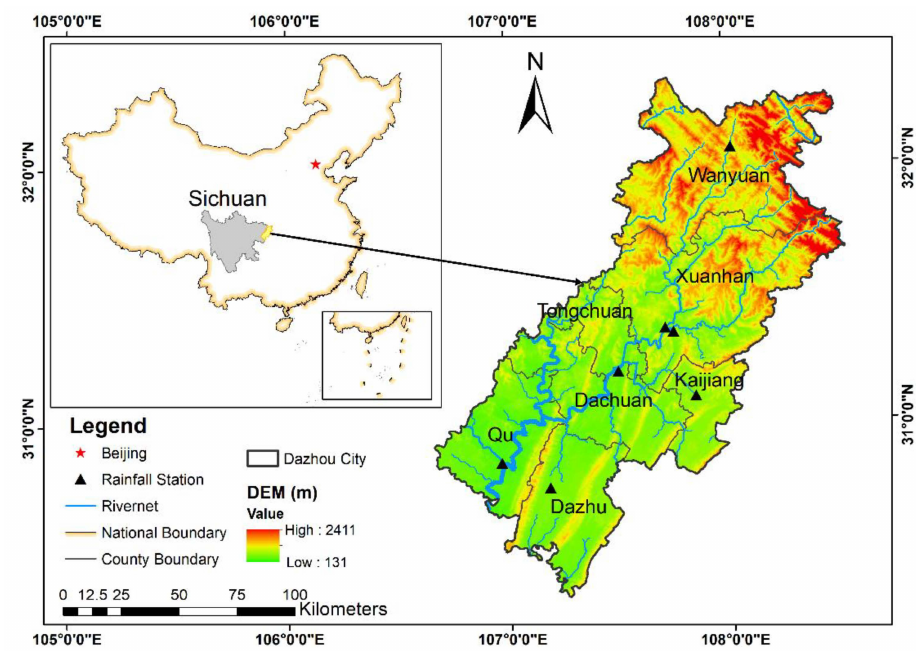
Figure 1. The location, DEM, rainfall station, and river net of the study area. As the climatic boundary between north and south China, Dazhou City has a subtrop- ical humid monsoon climate with frequent droughts and floods in summer and continuous rains in autumn. It has a forest coverage of 44.34% and annual average precipitation of about 1200 mm. It is hot and rainy simultaneously, and the annual average temperature is between 14.7 and 17.6 ◦ C. Due to the complex terrain, the regional climate varies greatly. The low mountains, hills, and valleys below 800 m have a mild climate and four distinct seasons; the low and middle mountain areas with an elevation of 800 to 1000 m are cool and damp; and the middle mountains above 1000 m have a long cold period with insufficient sunlight and heat